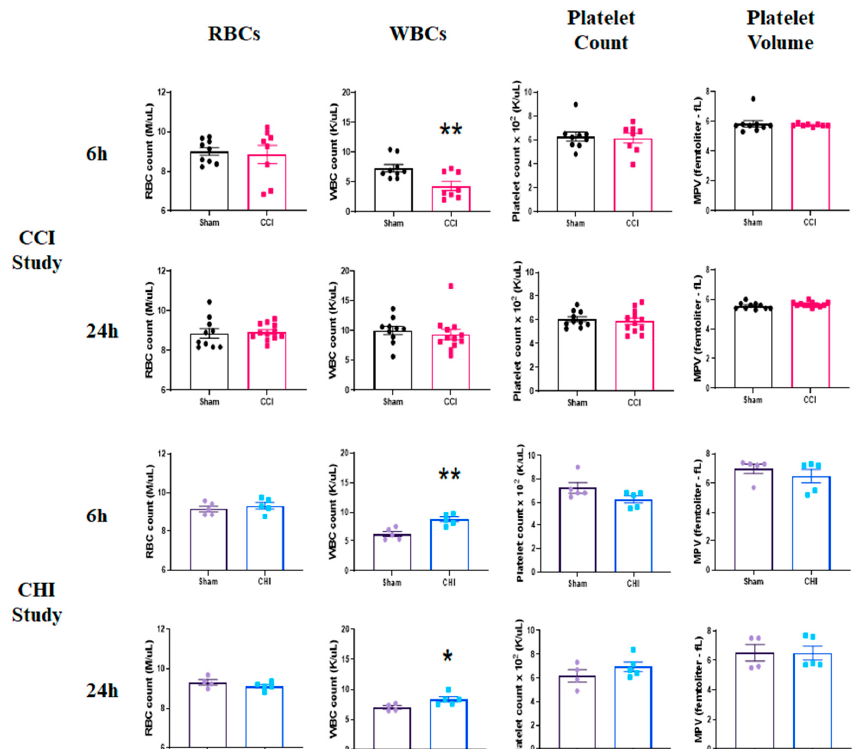
Figure 2. Early profile of blood cell alterations following contusion brain injury (CCI) and mild closed head impact (CHI). (Top Panels) Mice received either sham injury or severe CCI followed by euthanasia at either 6 or 24 h post-injury. Examination of RBC counts, WBC counts, platelet counts, and mean platelet volume (MPV) was performed by an IDEXX ProCyte Dx Analyzer. CCI does not alter RBC counts, platelet counts, or platelet volume at 6 or 24 h after injury. However, WBCs were significantly decreased after CCI compared to sham at 6 h post-injury before restoration at 24 h post-injury. ** p = 0.0076; t = 3.083. n = 8–9/group. (Bottom Panels) Mice received either sham injury or mild CHI followed by euthanasia at either 6 or 24 h post-injury. Examination of RBC counts, WBC counts, platelet counts, and mean platelet volume (MPV) was performed. CHI does not significantly change RBC counts, platelet counts, or platelet volume at 6 or 24 h after injury. However, WBCs were significantly increased after CHI compared to sham at both 6 and 24 h post-injury. ** p = 0.0039; t = 4.009. * p = 0.048; t = 2.397. n = 4–5/group. Mean ± SEM.